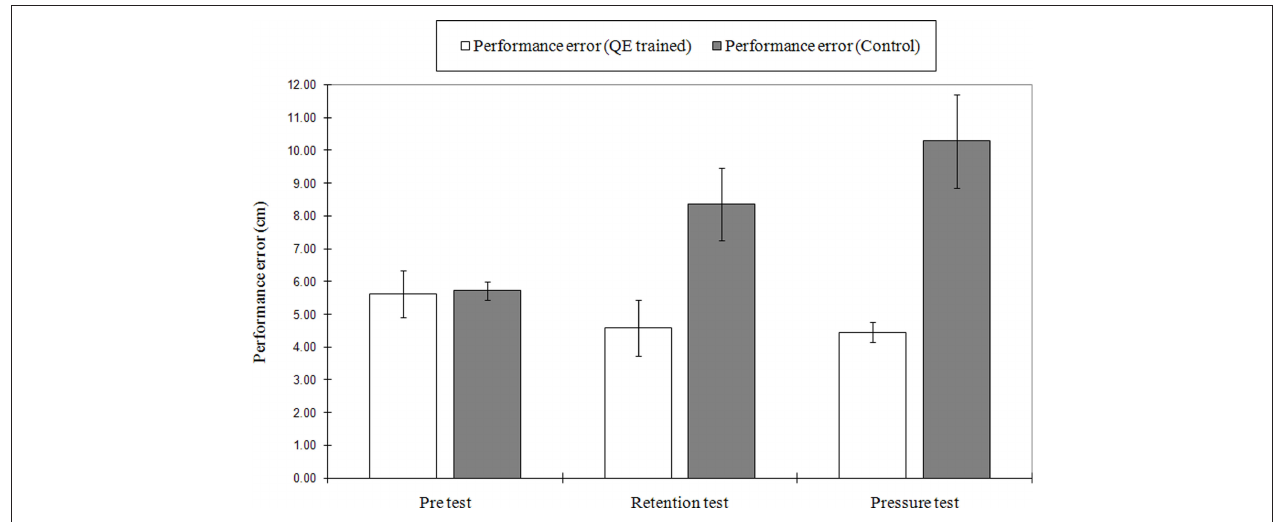
FiguRE 2 | Putting performance error (cm) for QE-trained and Control groups across pre-test, retention test, and pressure test conditions ( ± the Control group displayed significantly shorter QE durations (mean = 1404 ms) than the QE-trained group (mean = 2794 ms; Figure 1 ) under pressure. This reduction in the efficiency of goal-